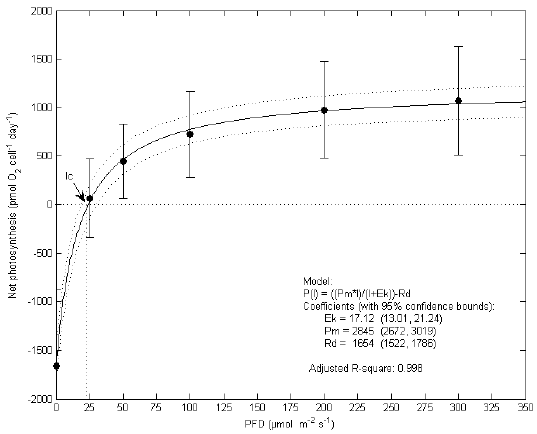
Figure 4. Net photosynthesis of Haynesina germanica (pmolO 2 cell − 1 d − 1 ) as a function of the photon flux density (PFD, µmolphotonsm − 2 s − 1 ) . The half-saturation constant, Ek, was found at 17 (13–21), the dark respiration, Rd, at 1654 (1522–1786) pmolO 2 cell − 1 d − 1 and the maximum photosynthetic capacity, Pm, at 2845 (2672–3019) pmolO 2 cell − 1 d − 1 . The Ic, calculated compensation irradiance (24 (17–30) µmolphotonsm − 2 s − 1 ) . The adjusted R 2 of the model was equal to 0.998, n = 3.